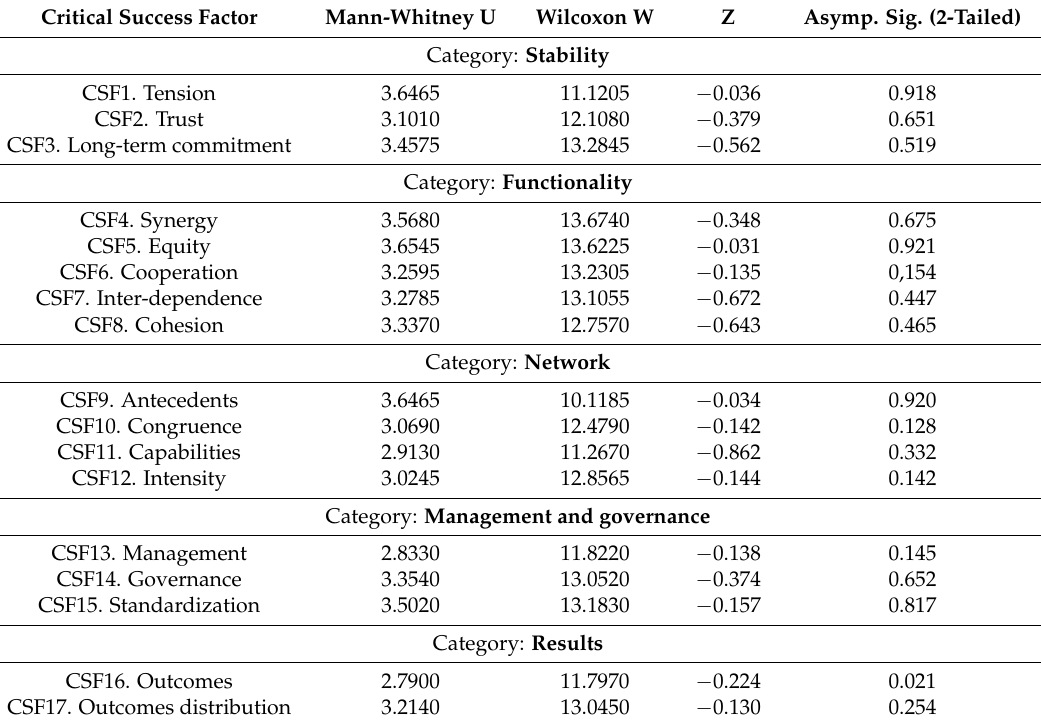
Table 3. The results of the independent sample t -test.